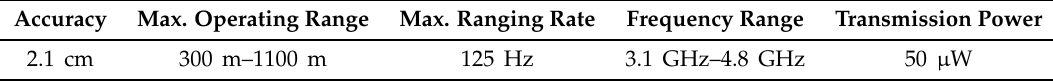
Table 3. The properties of the deployed P440 ranging sensor